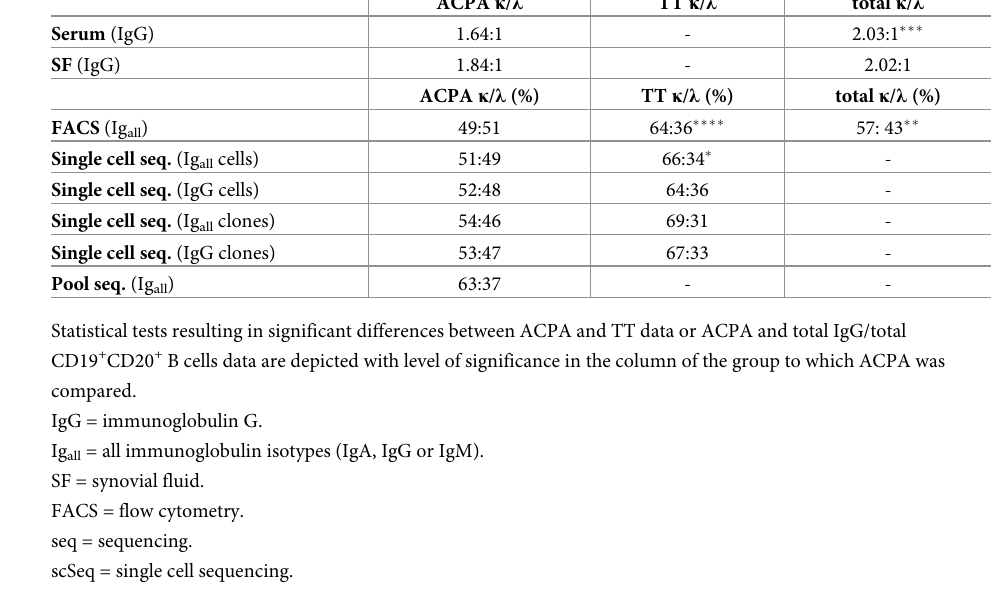
Table 1. Summary of all κ / λ LC ratios observed in ACPA-expressing, TT-specific and total IgG/total CD19 + CD20 + B cells as measured with ELISA, flow cytometry and BCR sequencing. ACPA κ / λ TT κ / λ total κ / λ Serum (IgG)